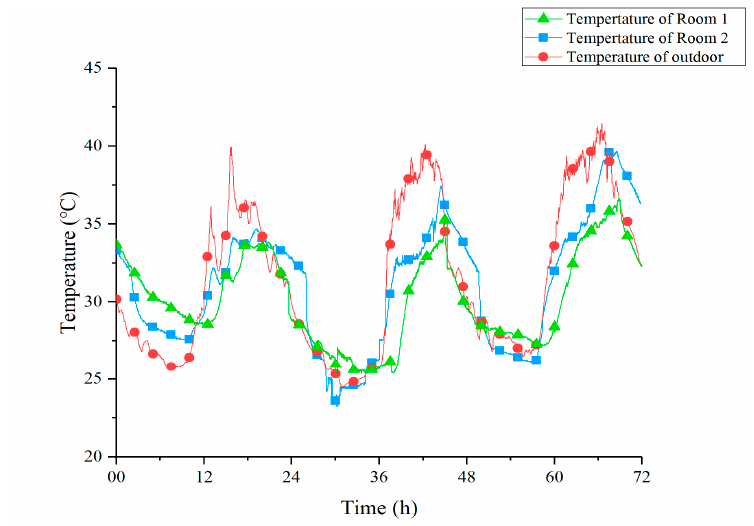
Figure 9. Temperature curves of Room 1, Room 2, and outdoor under Strategy 2. Table 8. Peak temperature comparison under Strategy 2.